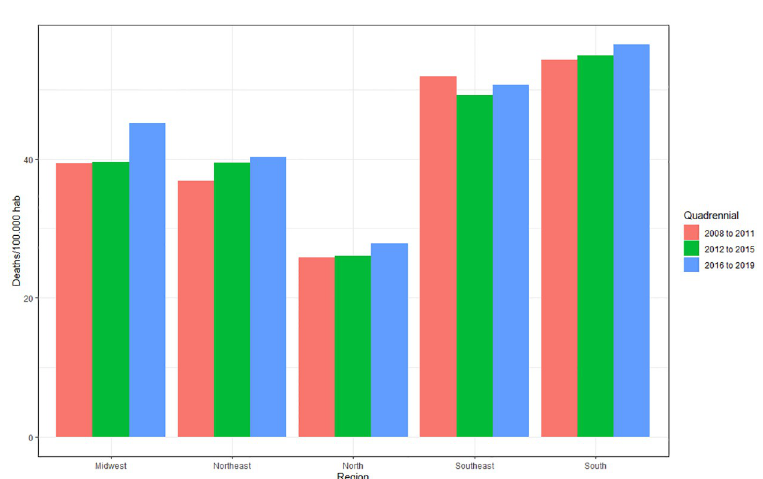
Fig 6. Average of deaths caused by cardiovascular diseases per 100 thousand inhabitants according to region of residence and quadrennium (2008 to 2011; 2012 to 2015; 2016 to 2019). Source: Brazilian Institute of Geography and Statistics (IBGE) and Ministry of Health–Hospital Information System of the Unified Health System (SIH/SUS) 2021.